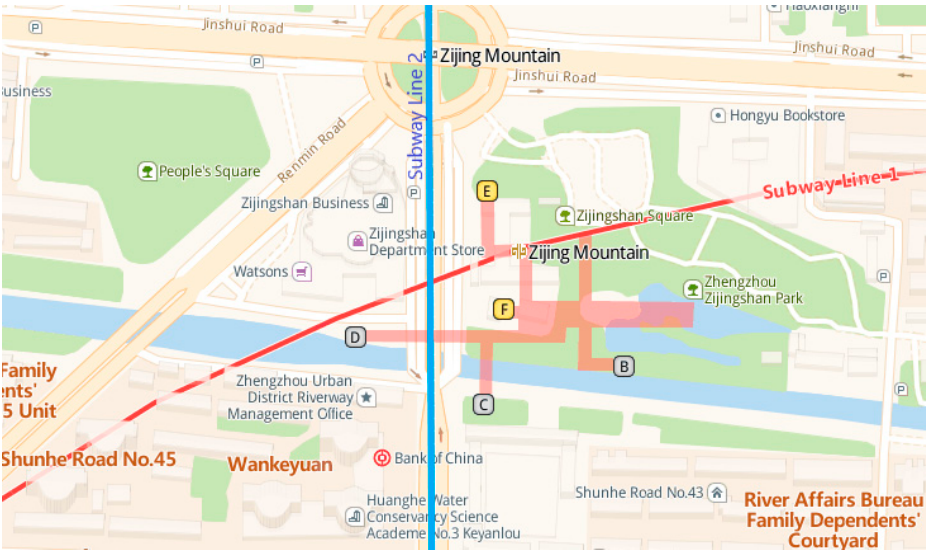
Figure 2. The geographical location of Zijing Mountain subway station in Zhengzhou, China (Note: This map can be accessed at the following website: https://lbs.amap.com/api/javascript-api/example/map/map-english/).